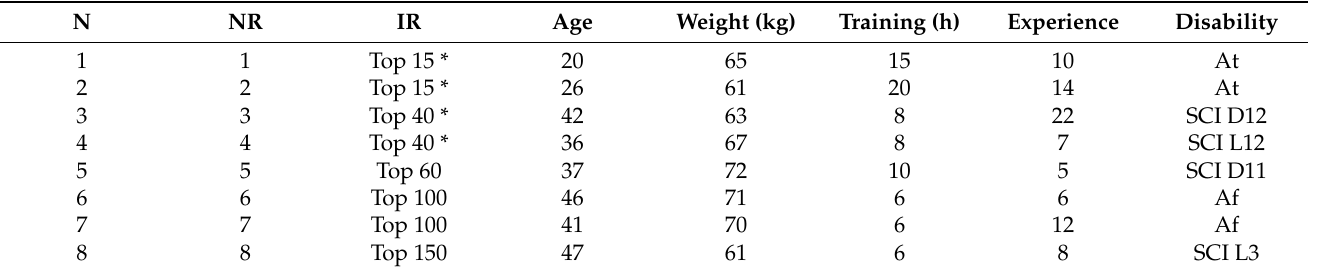
Table 1. Characteristics of the sample of wheelchair tennis players participating in the